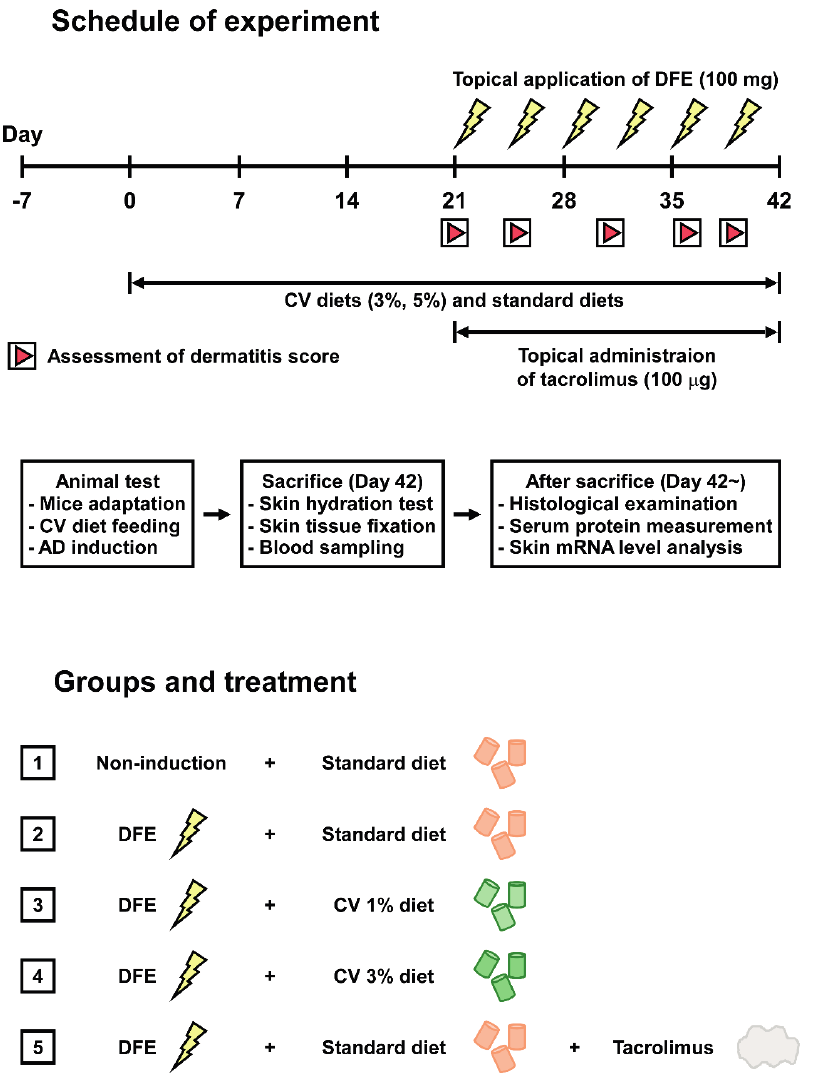
Figure 6. Experimental design overview. DFE: Dermatophagoides farinae extract; CV: Chlorella vulgaris ; AD: atopic